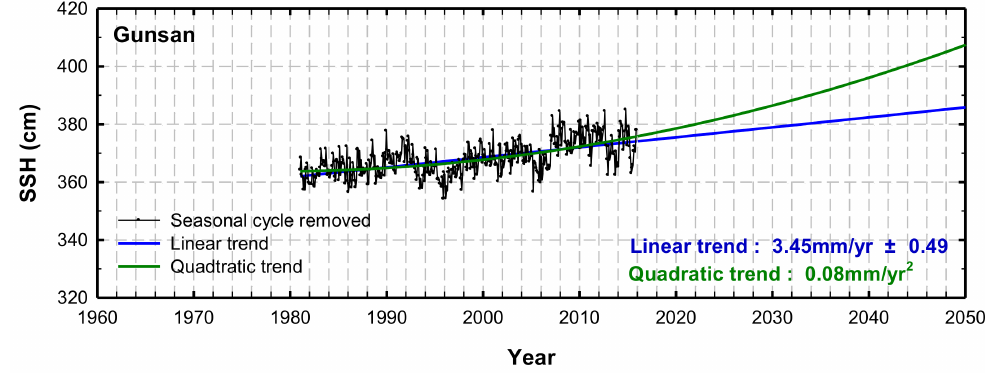
Figure 4. Sea level (black curve), fitted straight line (blue line, linear trend), and fitted quadratic line (green curve, quadratic trend) at the Gusan tide gauge